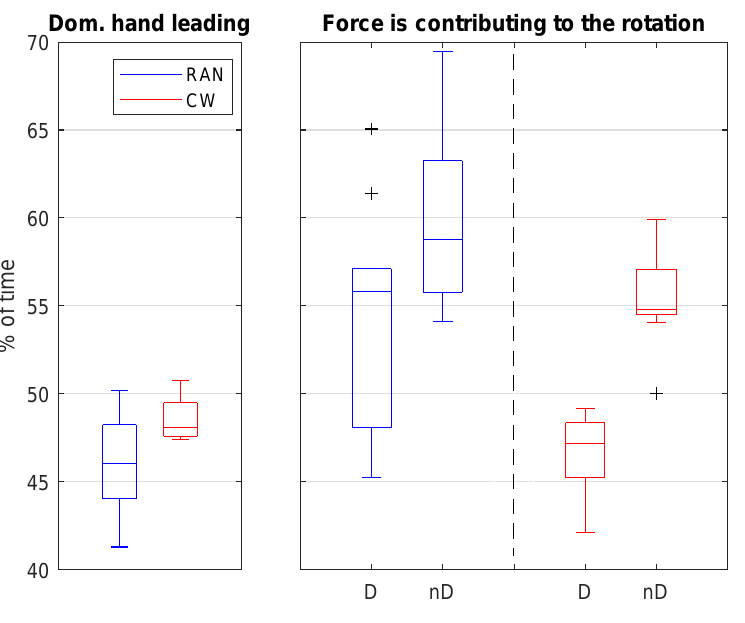
Figure 13. ( Left ): comparison of percentage of time the dominant hand spends leading the task, during the RAN and CW tasks. ( Right ): comparison of percentage of time in which both hands contribute to the handlebar rotation, during RAN and CW